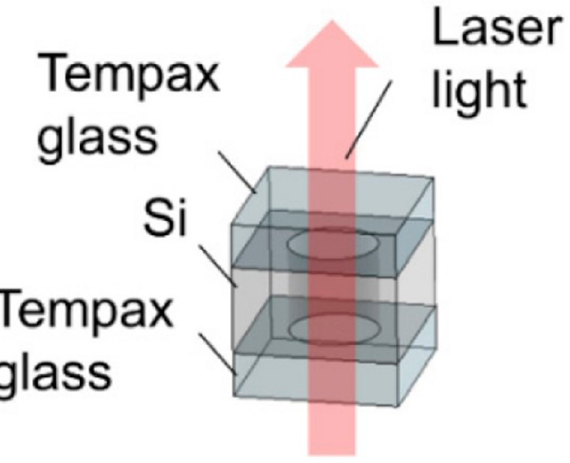
Figure 1. Silicon–glass anodically bonded alkali vapor cell. Reprinted from Ref